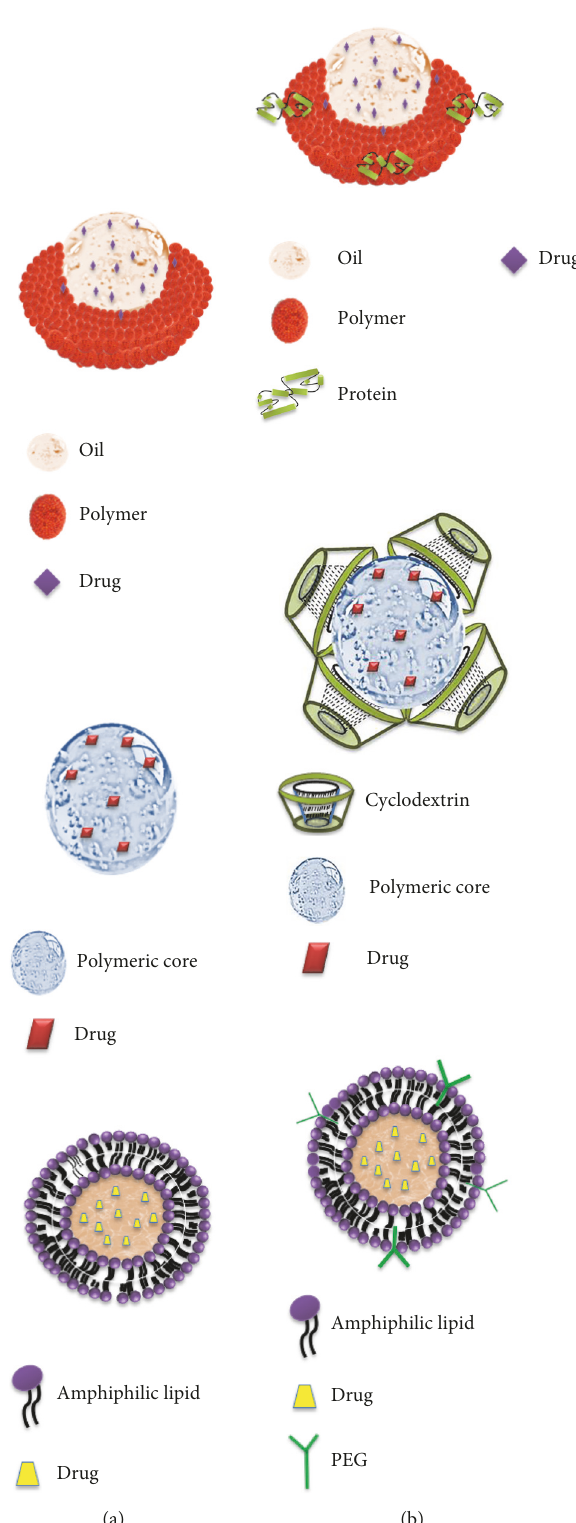
Figure 2: Schematic representation of some traditional nanocarriers’ structures (a) and their respective organic biohybrid systems